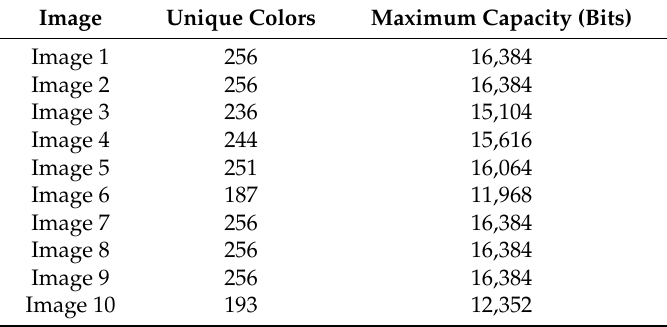
Table 1. Computational results for unique colors and maximum capacity of images of Figure